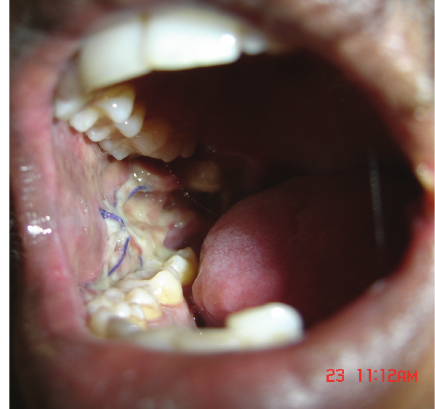
Figure 7: After 1 week.